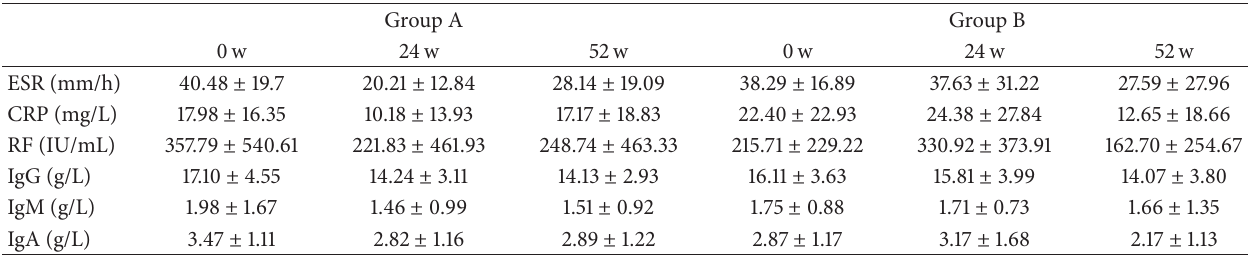
Table 2: Experimental assessment of RA patients undergoing iguratimod